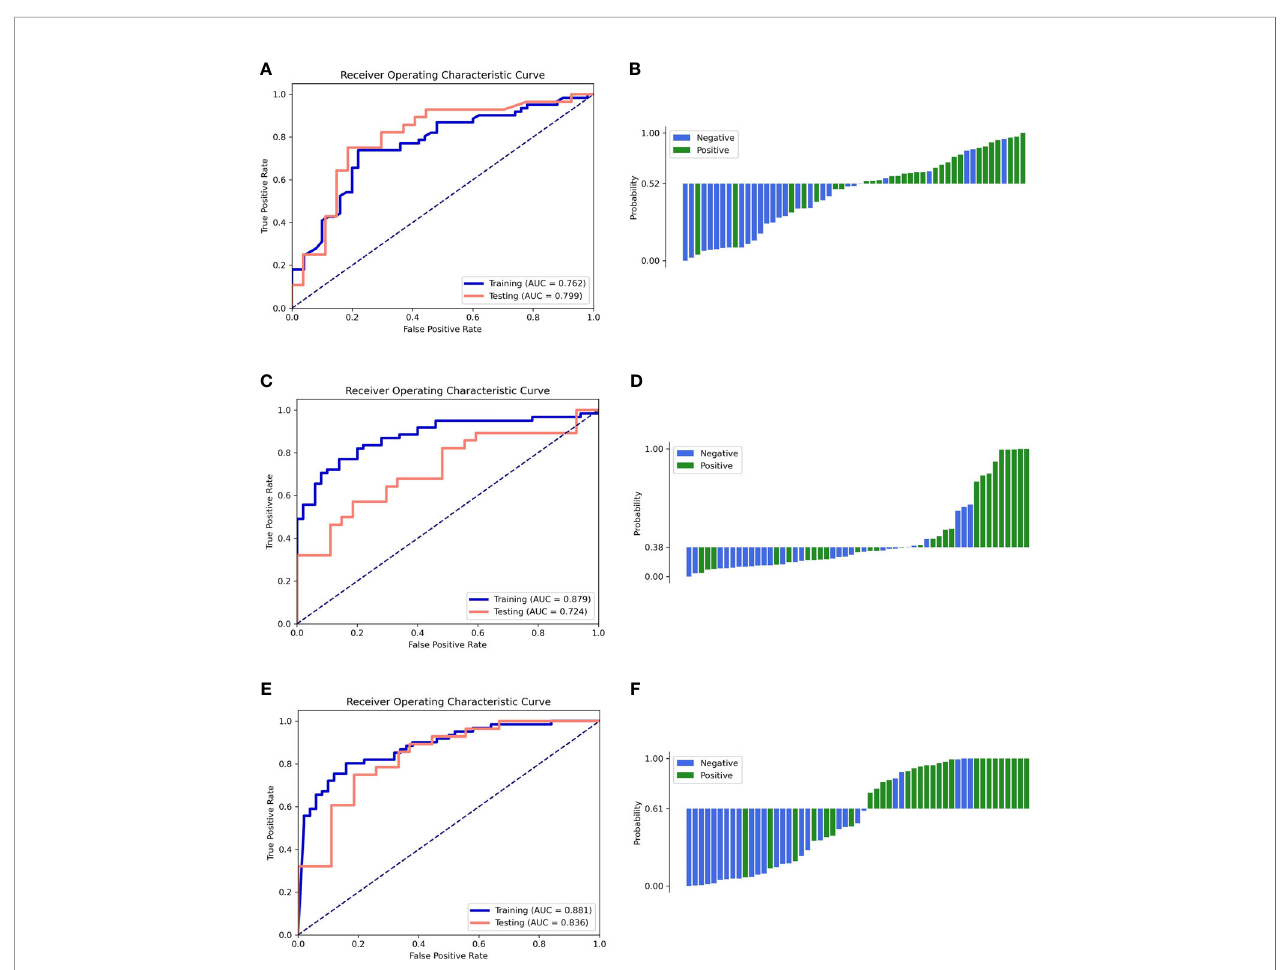
FIGURE 2 | ROC curves of the training and testing cohorts (left column) and the waterfall plot of the distribution of prediction probability on the testing cohort (right column). (A, B) Clinical model. (C, D) Radiomics model. (E, F) Clinical – radiomics model.